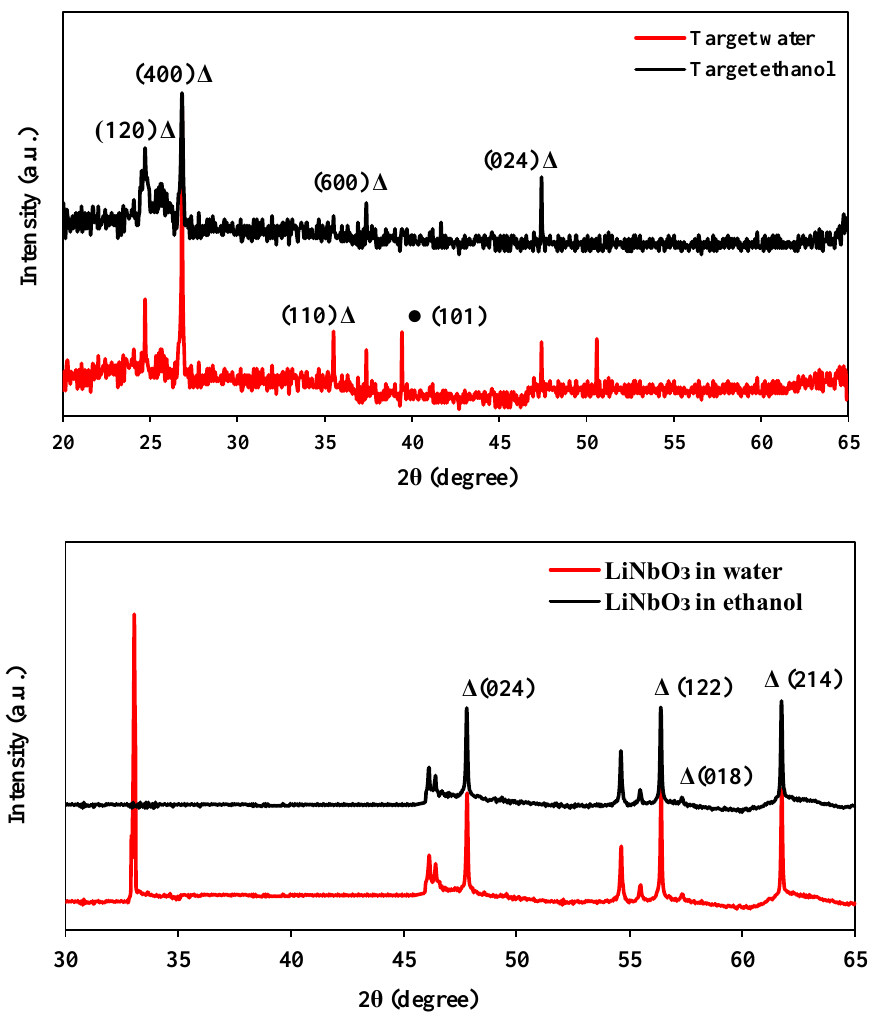
Figure 6: XRD of lithium-niobate thin films (a) LN pellet, (b) LN